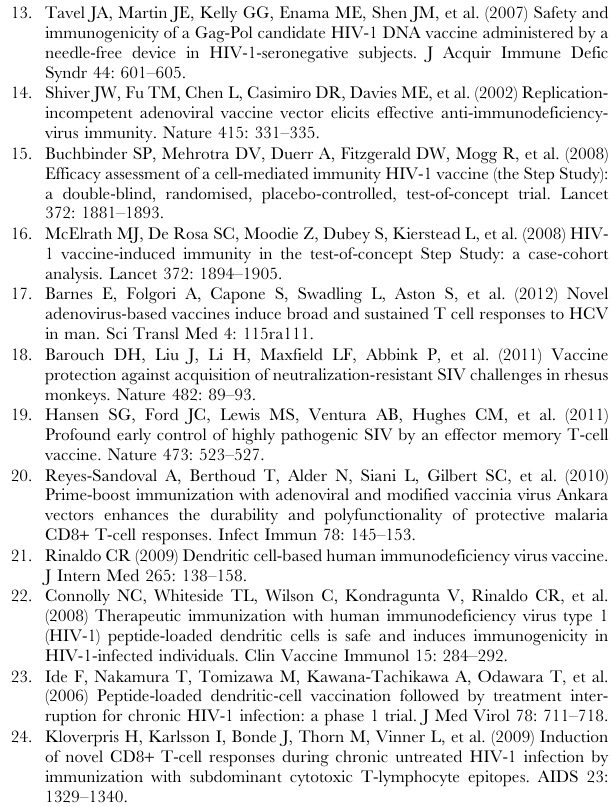
Figure S1 Magnitude of pre-existing HIV Rev, Nef and Tat specific responses. Eighteen subjects completing the study were tested for IFN c ELIspot responses expressed as SFU per million inpuT-cells to HIV peptide pools Rev, Nef, Tat or mock (media only) from fresh ex vivo PBMCs obtained from screening samples available at 2–6 weeks prior to baseline. Figure S2 HIV Rev, Nef, Tat and CMV peptide pool specific responses before and after vaccination. All six subjects from each dose group (0 mg, 12 mg and 24 mg) were tested for HIV Rev, Nef, Tat and CMV peptide specific responses or no peptide by IFN c ex vivo ELIspot performed from fresh cells at week 0, 10, 12, 13, 14 and 16 after first vaccination expressed as median values within dose groups with error bars representing inter quartile ranges. Figure S3 FACS plots showing CD8 + T-cell gating strategy (top panel) with effecter producing CD8 + T-cells shown after no stimulation, OPAL-HIV-Gag(c) or SEB stimulation at week 13 for subject 005 (A) and shown as boolean gated polyfunctional pie charts examining CD107a/IFN c /IL2/MIP1 b producing total CD8 + T-cells at 3 time points for subject 005 (B). Figure S4 Subject individual CMV peptide pool specific CD8 + T-cell responses before and after vaccination. All six subjects from each dose group (0 mg, 12 mg and 24 mg) were tested for CMV specific responses by ICS shown as IFN c + / MIP1 b + double positive CD8 + T-cells processed from frozen